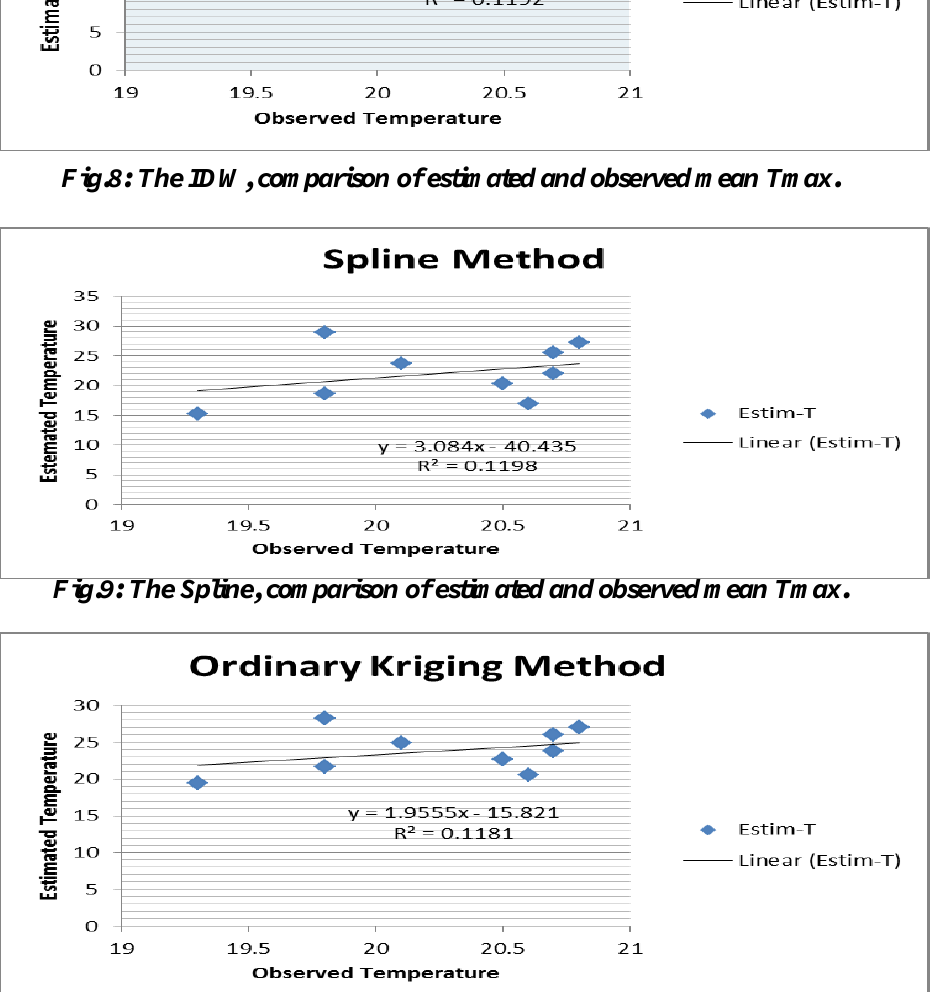
Fig.10: Ordinary kriging, comparison of estimated and observed mean